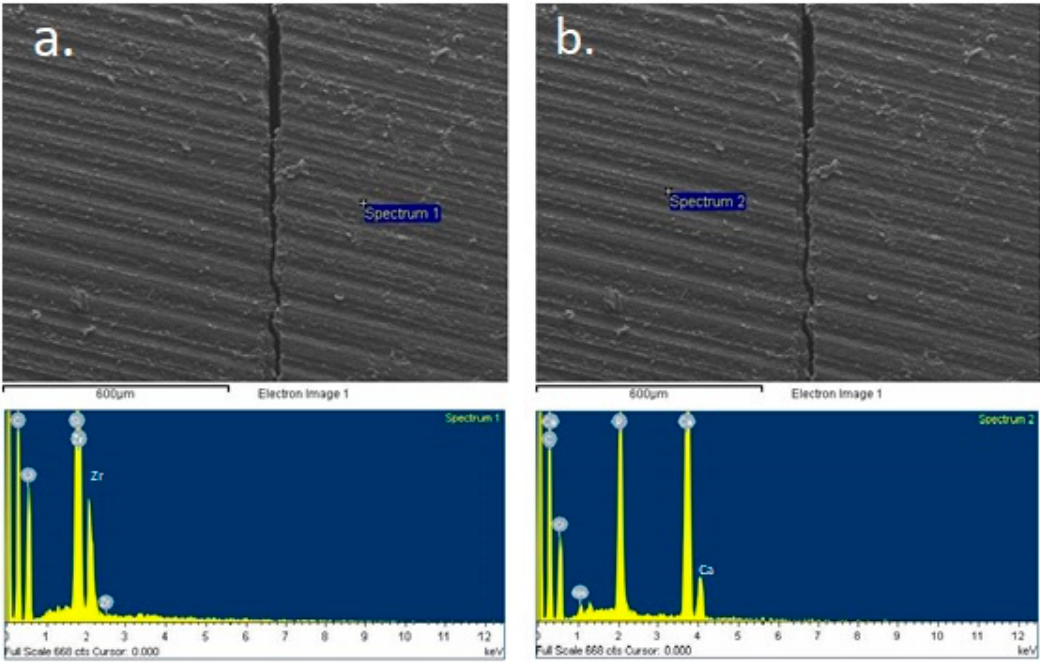
Figure 2. Representative SEM images of the material/dentin interface, where the structures were defined by using energy-dispersive X-ray spectroscopy: ( a ) elemental analysis of the right side of the SEM image indicating composite material; ( b ) elemental analysis of the left side of the same SEM image indicating dentin.